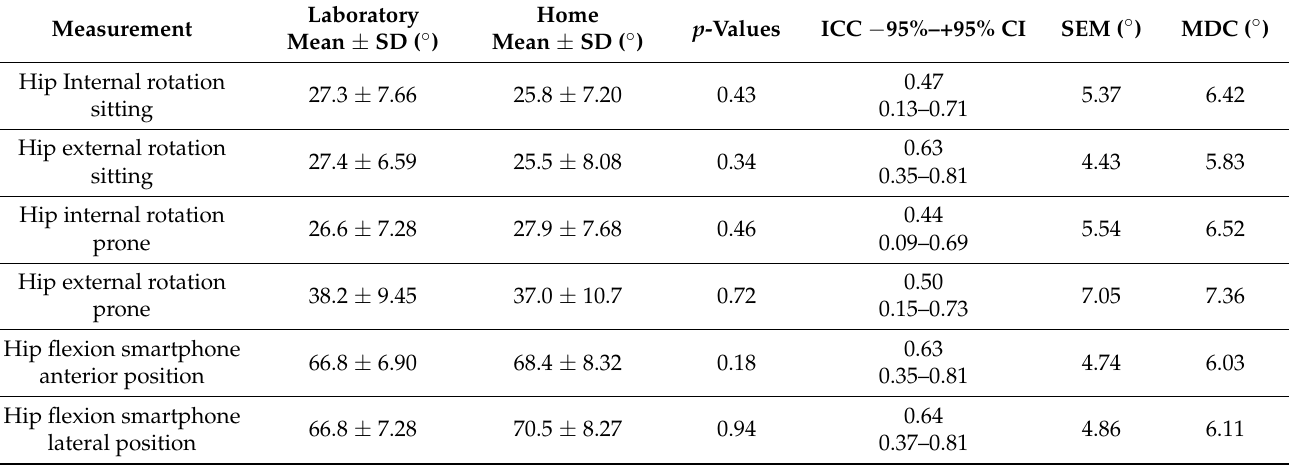
Table 3. Comparison of smartphone (TelePhysio) measurements in the laboratory and at home: means ± standard deviations, one way ANOVA p -value, ICC and 95% confidence intervals, SEM, and MDC.